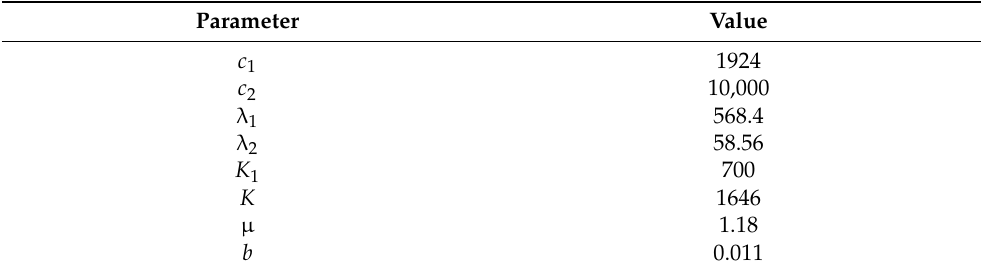
Table 2. Main parameters of the calibration